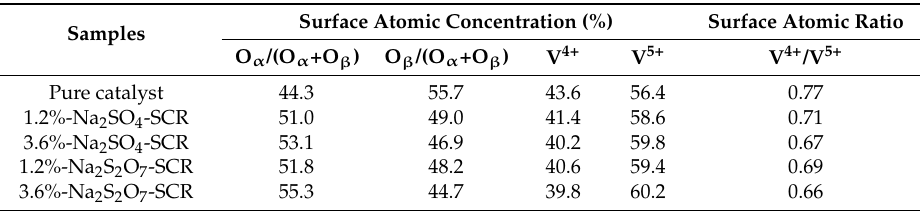
Table 2. The states of O and V on the catalyst surfaces.